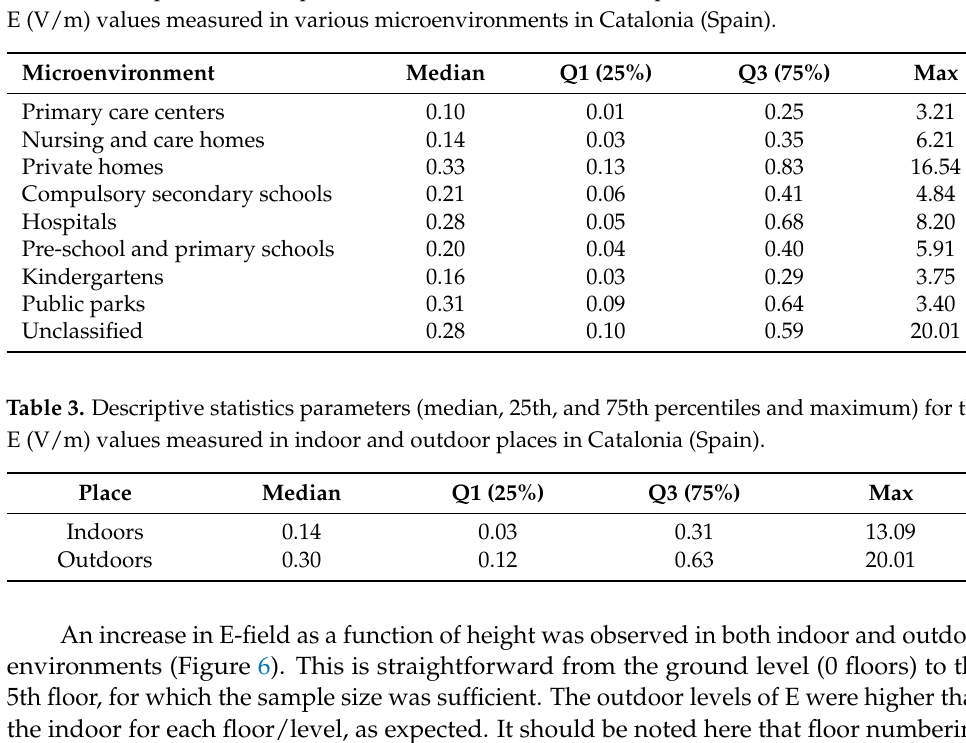
Table 4. Descriptive statistics parameters (median, 25th, and 75th percentiles and maximum) for the E (V/m) values measured in various microenvironments in France. Microenvironment